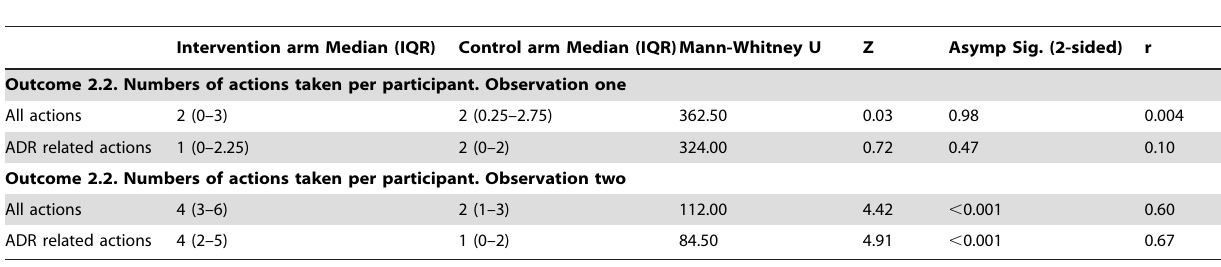
Table 5. Numbers of actions taken per participant: Outcome